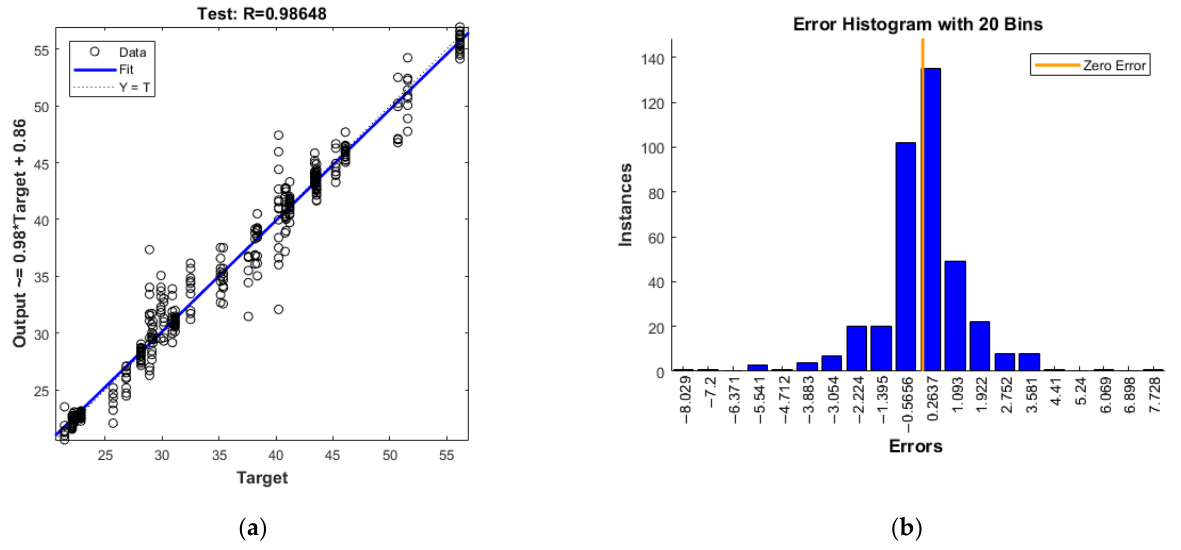
Figure 3. Results of the linear regression ( a ) and error histogram ( b ) for the test dataset and the MLP 33-10-1 TS10 model for the prediction of the total solids content.